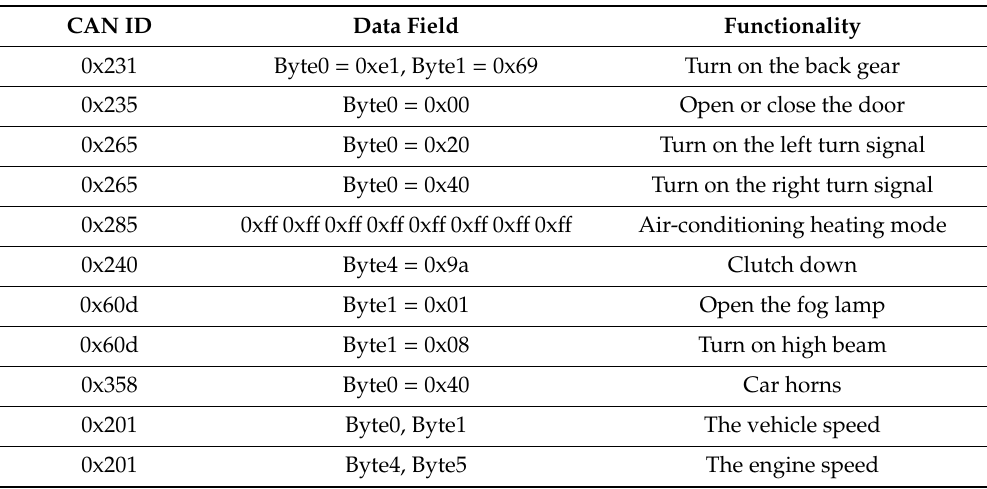
Table 5. Diagnostic services of the Ford vehicle.